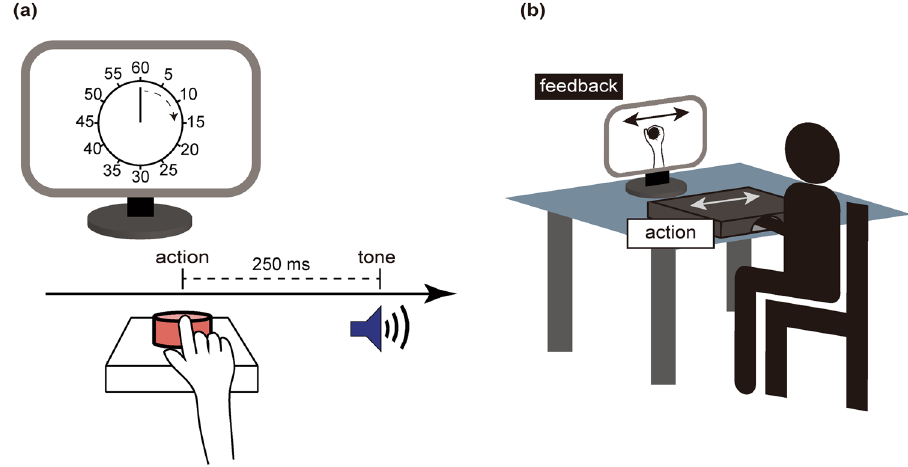
Figure 3. Illustration for experimental setups and protocols for ( a ) Experiment 1 and ( b ) Experiment